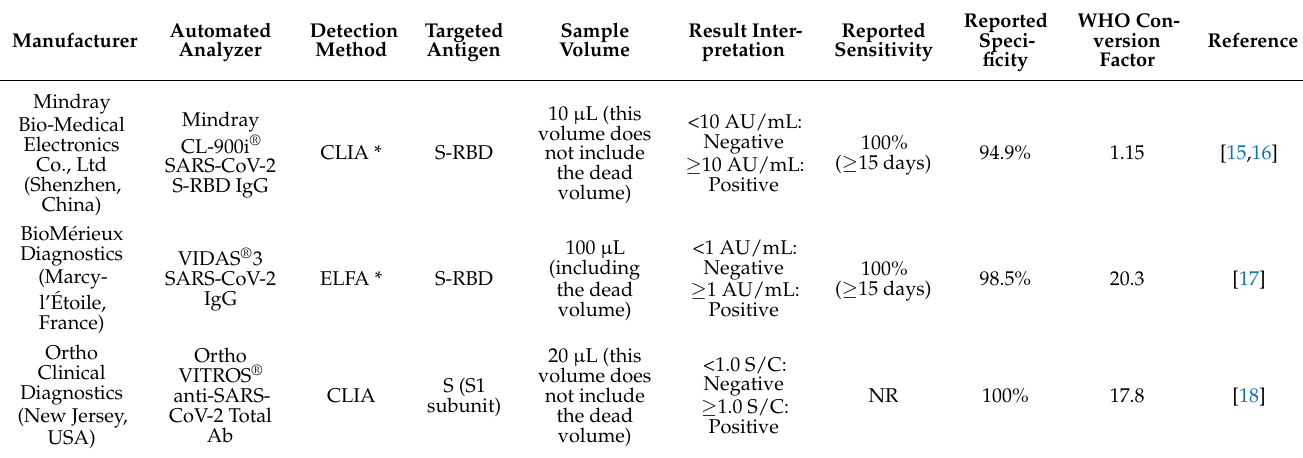
Table 1. Characteristics of the automated analyzers used in this